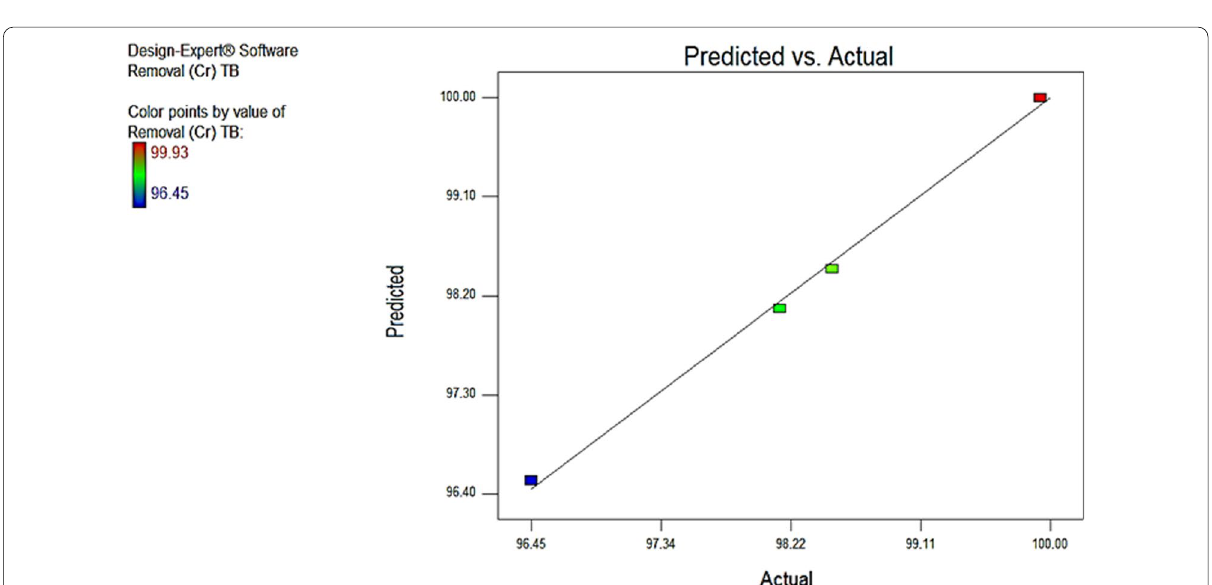
Fig. 5 A cross-validation plot predicted response against actual values of response from selected factorial model on the removal of chromium when tea bag residues are used as